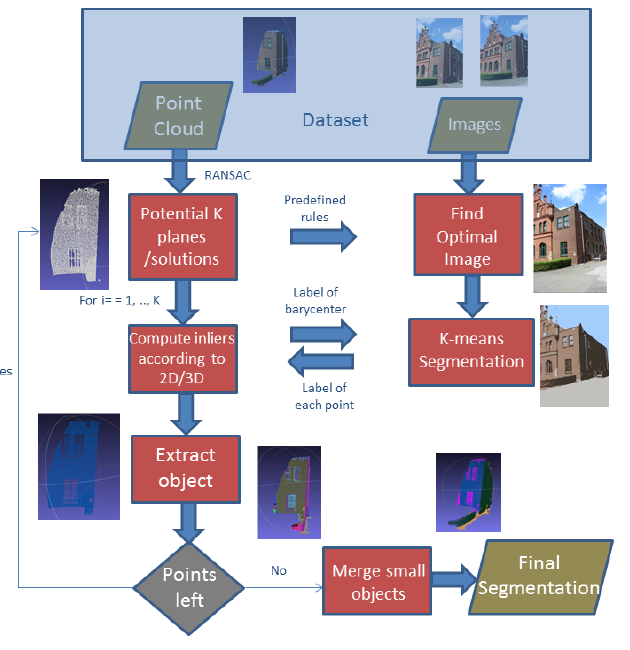
Figure 1. The flowchart of